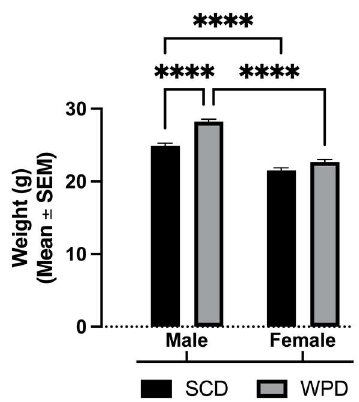
Figure 1. Adult weights (in grams) of offspring by diet and sex. SCD = standard chow diet, WPD = western-pattern diet. **** p < 0.0001.